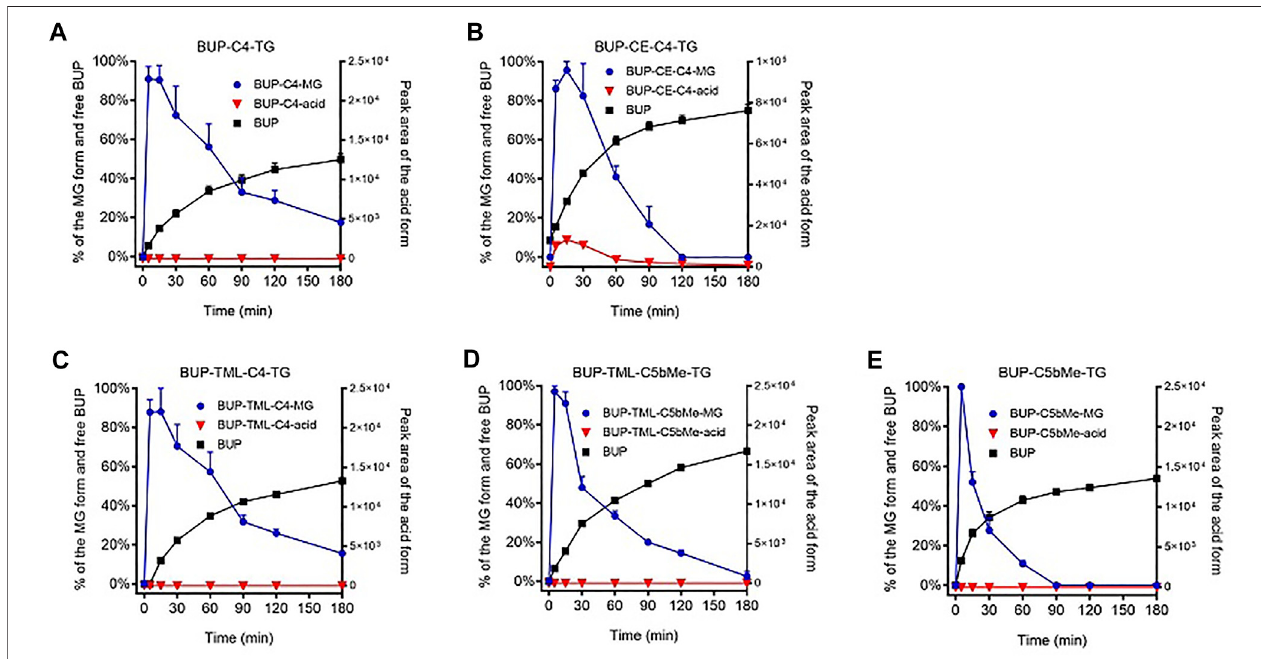
FIGURE5| Invitro prodrugconversionpro fi le.Data(Mean±SEM, n =3)areshownas%masschangeofMG-likeformsandparentBUP,oraspeakareaforBUP- linker-acid forms, upon in vitro incubation of BUP-C4-TG (A) , BUP-CE-C4-TG-TG (B) , BUP-TML-C4-TG (C) , BUP-TML-C5bMe-TG (D) , and BUP-C5bMe-TG (E) with rat plasma supplemented with lipoprotein lipase (LPL).